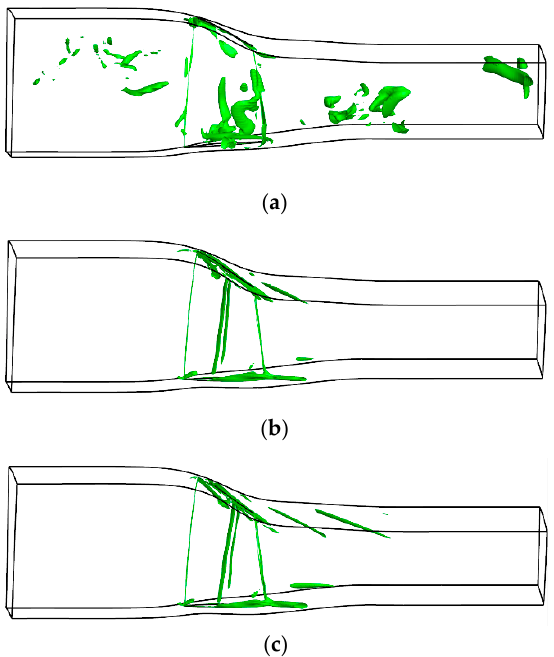
Figure 12. Iso − surface of Liutex value 1.7 × 10 4 in the NASA rotor 37 at ( a ) NS condition, ( b ) design condition, ( c ) NC condition.